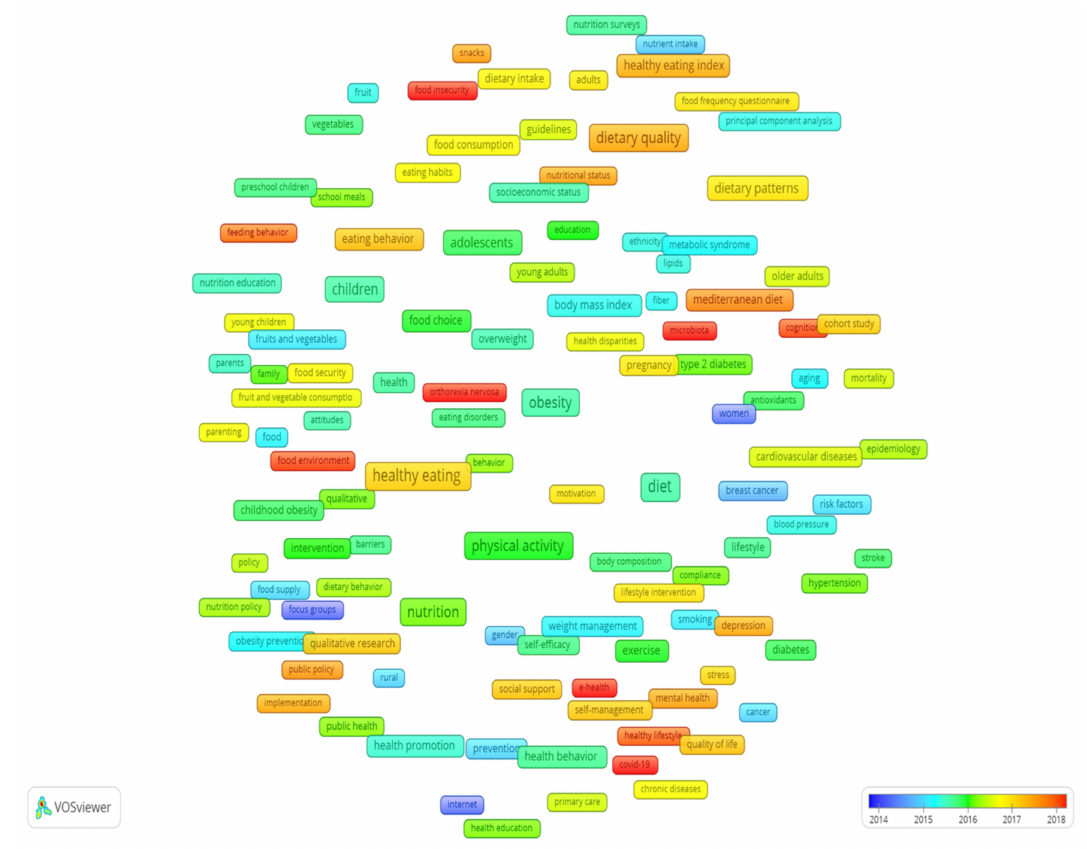
Figure 4. The overlay map of the 137 high-frequency